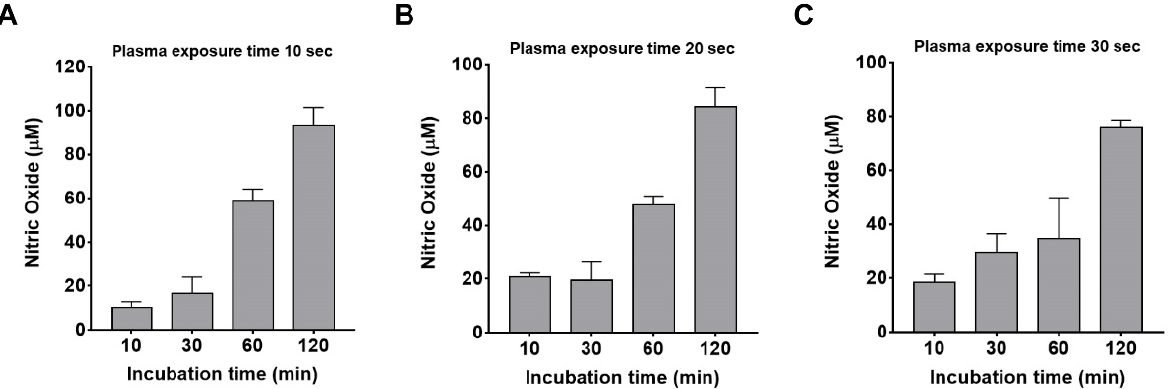
Figure 8. Plasma-induced nitric oxide in the keratinocytes. ( A – C ) Argon plasma was applied to keratinocytes for 10 ( A ), 30 ( B ), and 60 ( C ) seconds, followed by incubation for 10, 30, 60, and 120 min. Intracellular nitric oxide levels were measured by quantitative colorimetry at 540 nm from keratinocytes. Data are presented as means ± S.D. n = 3 independent samples per group.